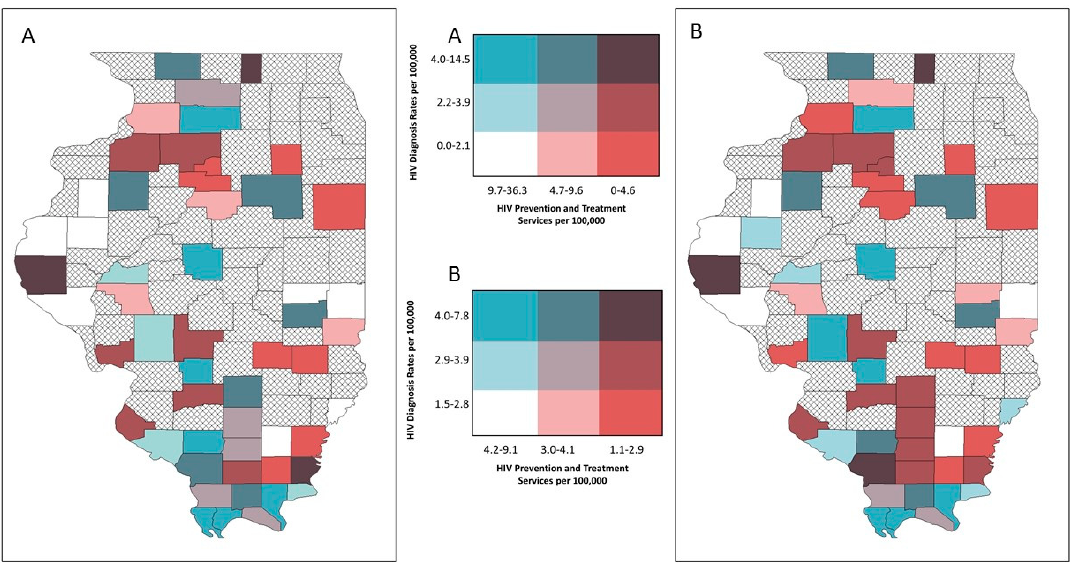
Figure 9. Bivariate choropleth maps of local health department services and disease burden, respondent rural counties, Illinois: HIV prevention and treatment services and HIV diagnosis rates; ( A ) crude rates ( B ) empirical Bayes estimated rates.